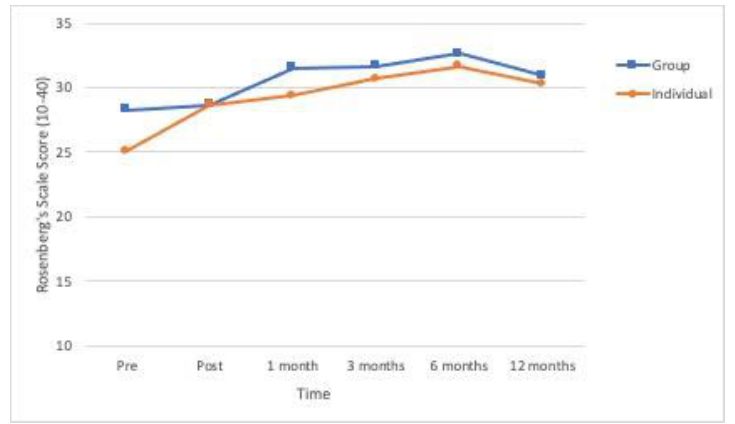
Figure 5. Evolution over time of the levels of self-esteem (Rosenberg’s Self-Esteem Scale) in the two experimental conditions ( n = 53).